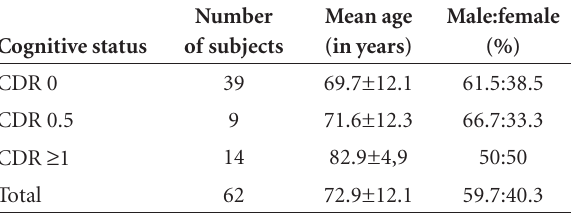
Table 2. Demographic data of the 62 subjects included in this study.